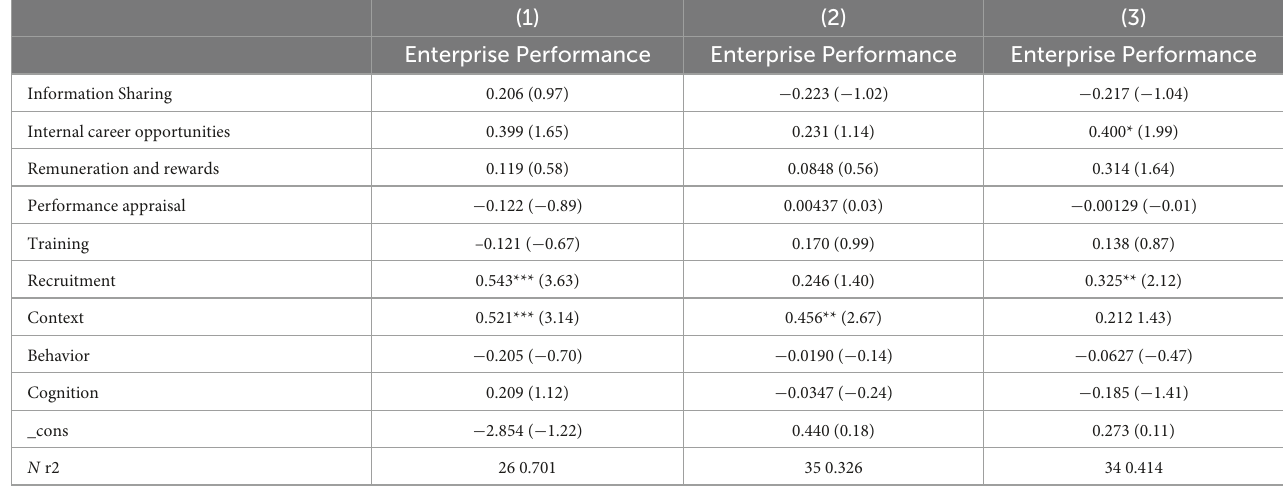
TABLE 6 Results of group regression and difference test at different